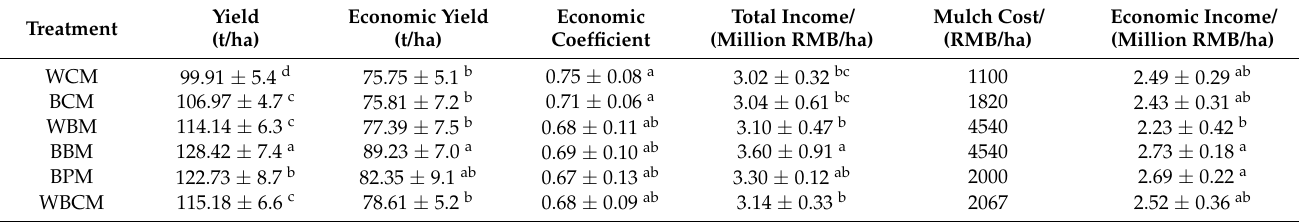
Table 3. Analysis of different treatments on the yield and economic benefits of cabbage.